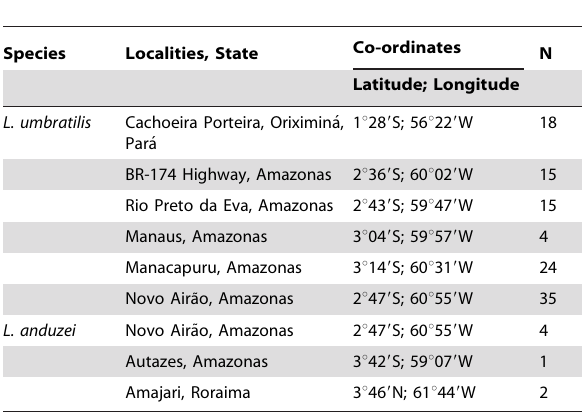
Table 1. Collection sites and sample sizes of Lutzomyia umbratilis and Lutzomyia anduzei from Amazonian